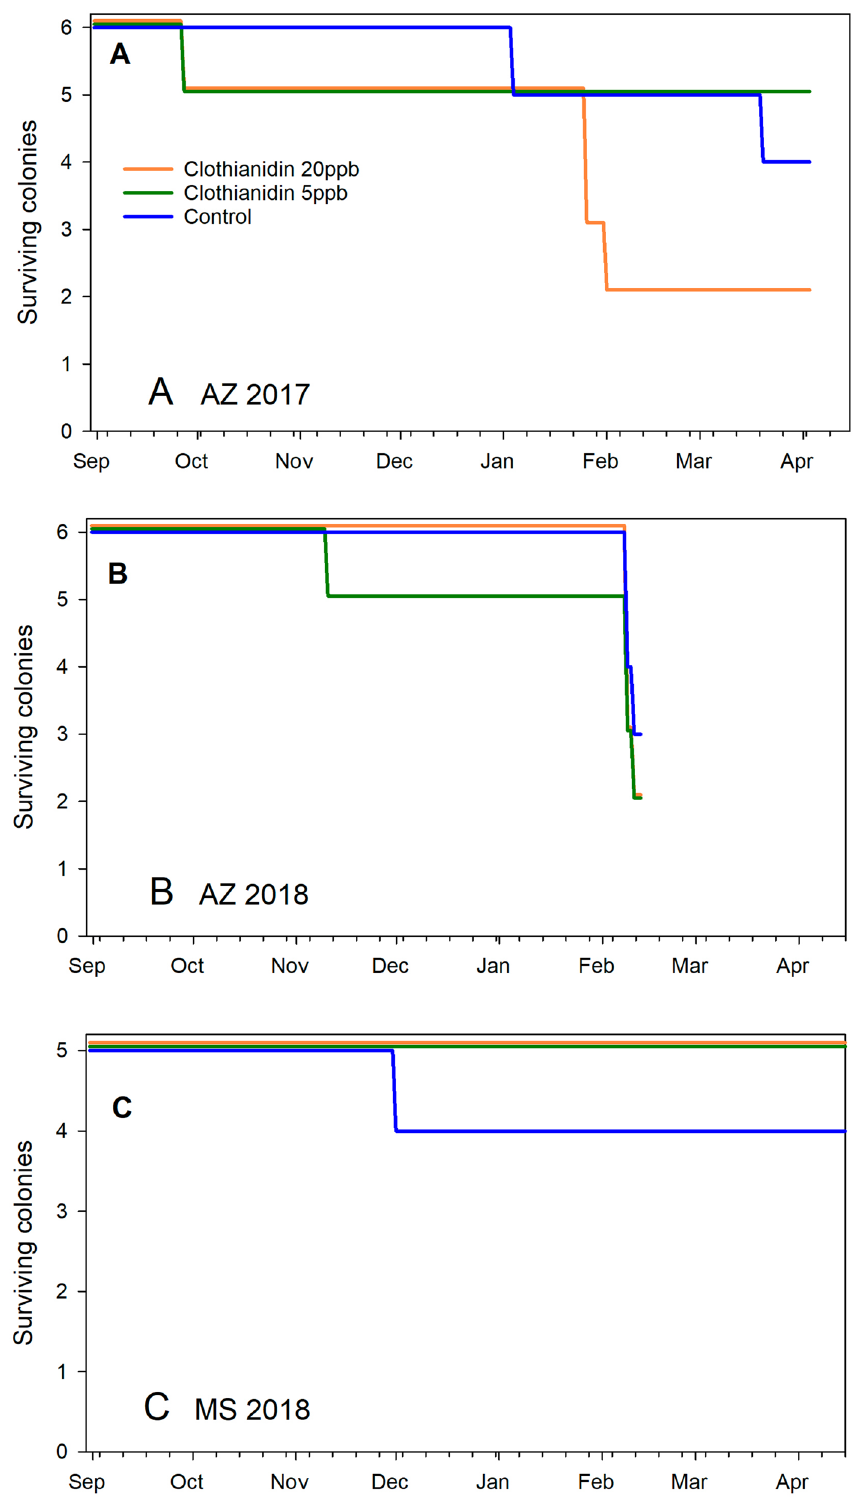
Figure 1. Honey bee colony survivorship from 1 Sept. to 15 April for each of the 3 treatment groups: Clothianidin 20-ppb (orange), clothianidin 5-ppb (green), control (blue) across 3 experiments. ( A ) AZ 2017; ( B ) AZ 2018; ( C ) MS